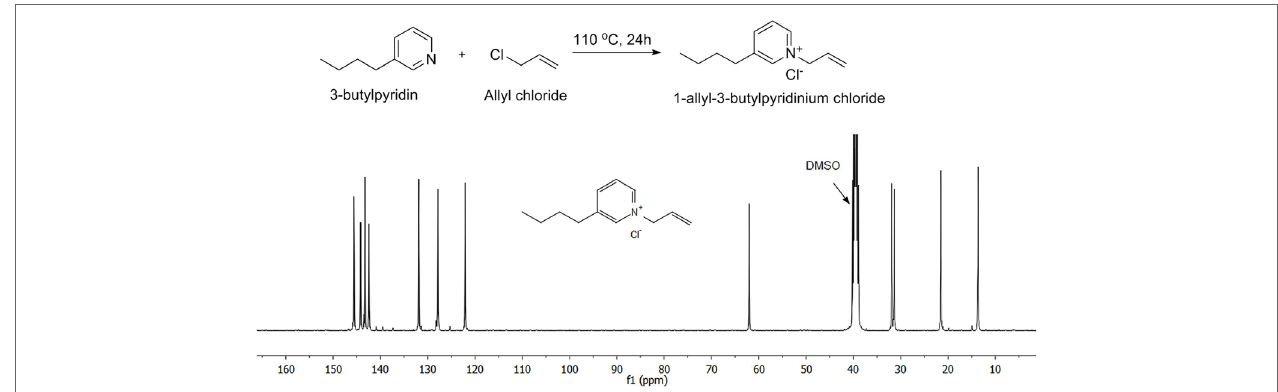
FigUre 1 | Synthesis pathway and 13 C NMR result for the 1-allyl-3-butylpyridinium chloride ionic liquid.